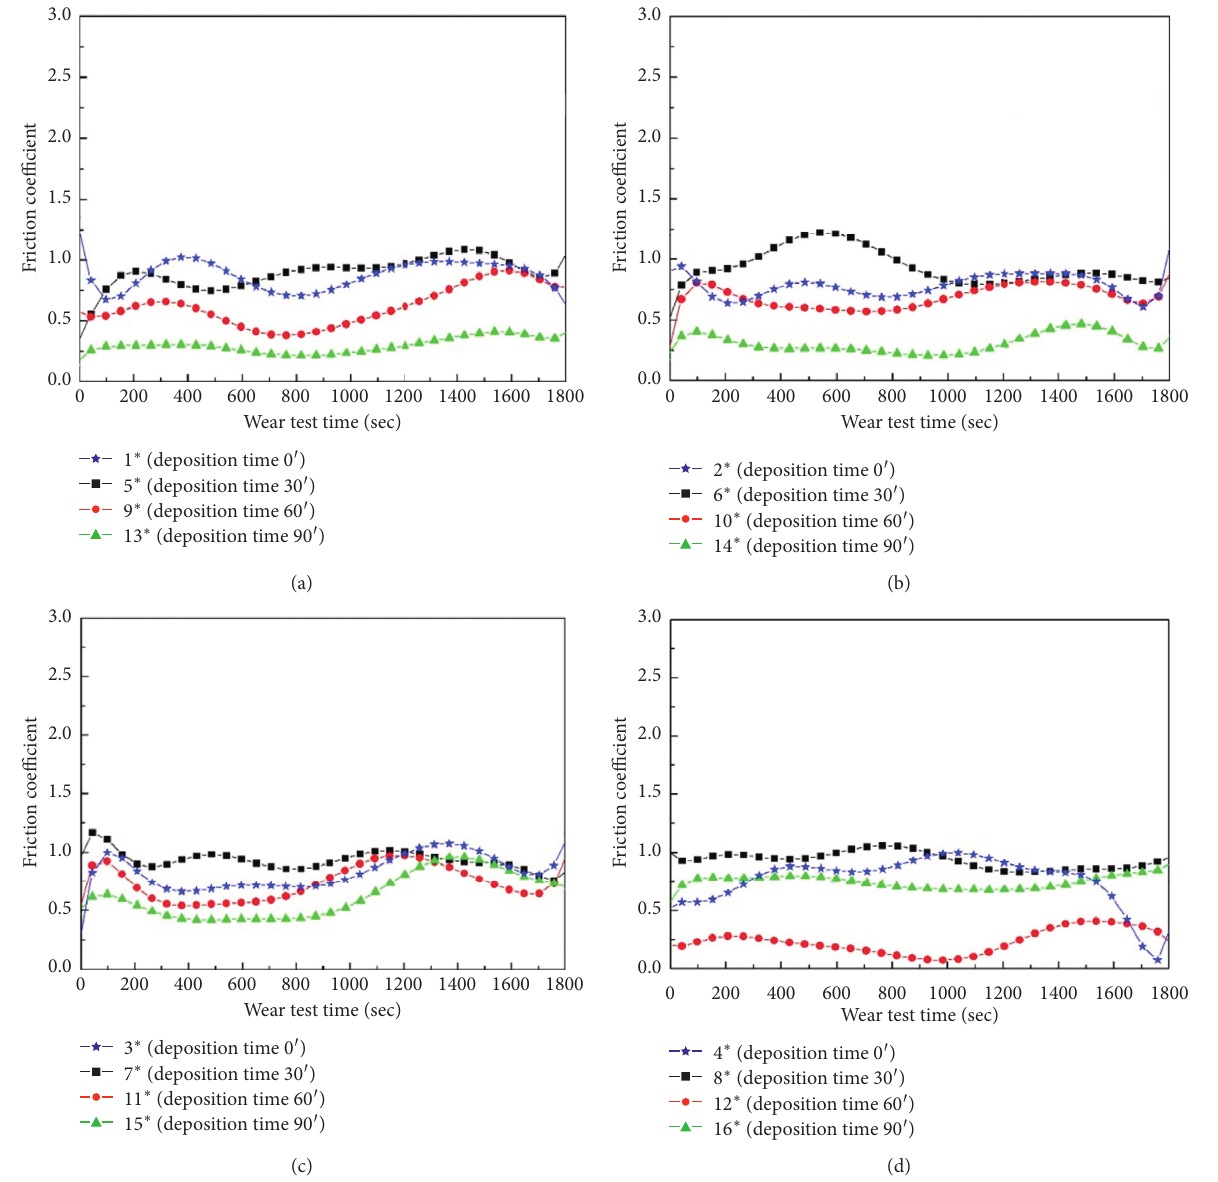
Figure 3: Friction coefficient graph by surface roughness: (a) polished with #400; (b) polished with #800; (c) polished with #1200; (d) polished with #alumina.